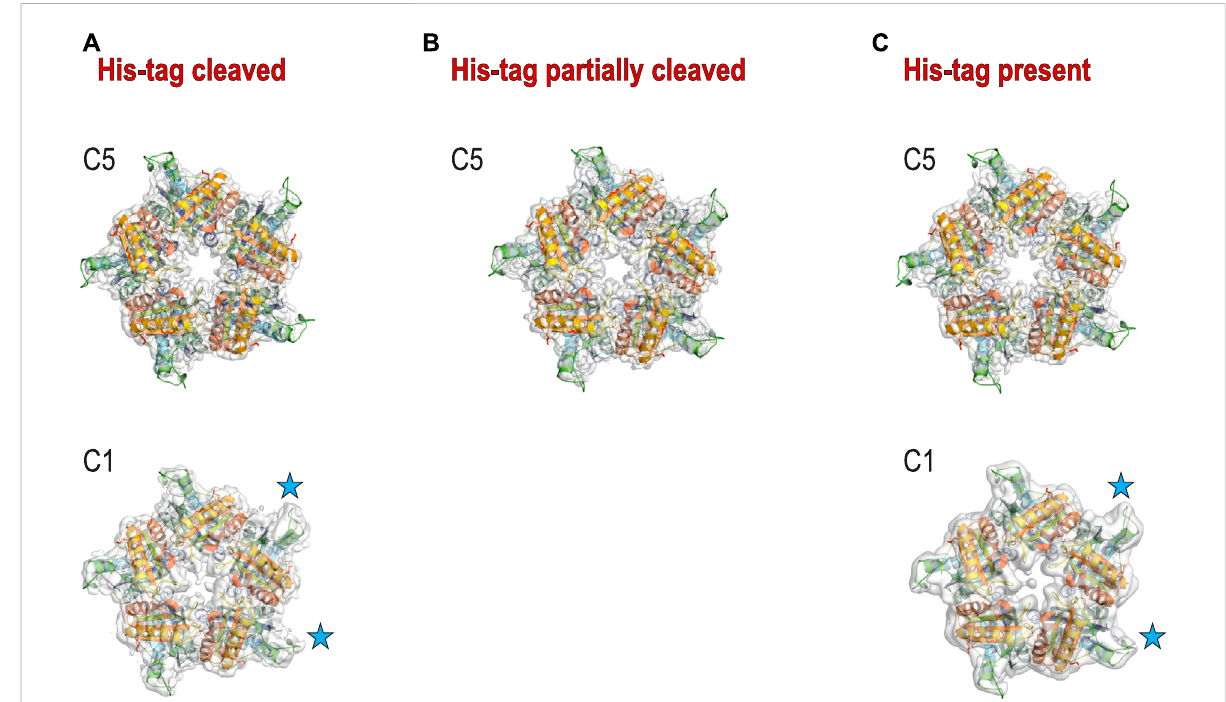
FIGURE 4 3D reconstructions for three samples. (A) 3D reconstruction with C5 (top) and C1 (bottom) symmetries for the sample with His-tag cleaved; (B) 3D reconstruction with C5 symmetry for the sample with His-tag partially cleaved. The reconstruction with C1 symmetry did not provide the interpretable density. (C) 3D reconstruction with C5 (top) and C1 (bottom) symmetries for the sample with His-tag uncleaved. The blue stars denote the 2 loops that have the best density in C1